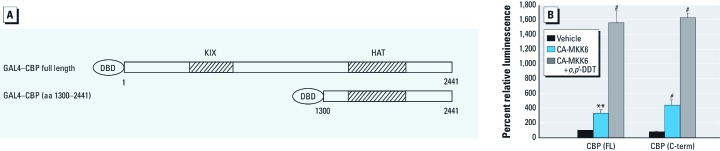
DDT and p38α target the C‑terminal of CBP. (A) Schematic of GAL4-CBP fusion constructs used for mammalian one-hybrid analysis; aa, amino acids. (B) HEK 293 cells transfected for 6 hr with full-length GAL4-CBP (FL) or the C‑terminal (C‑term) fragment GAL4-CBP (aa 1300-2441) plus GAL4‑luc. Some cells were also transfected with the CA-MKK6 mutant; other cells were transfected with MKK6-CA and incubated overnight with 50 μM o,p’‑DDT. Values represent the percent change (mean ± SE; n = 4) in CBP activity, with the vehicle set to 100%. **p < 0.01, and #p < 0.001 compared with vehicle control.